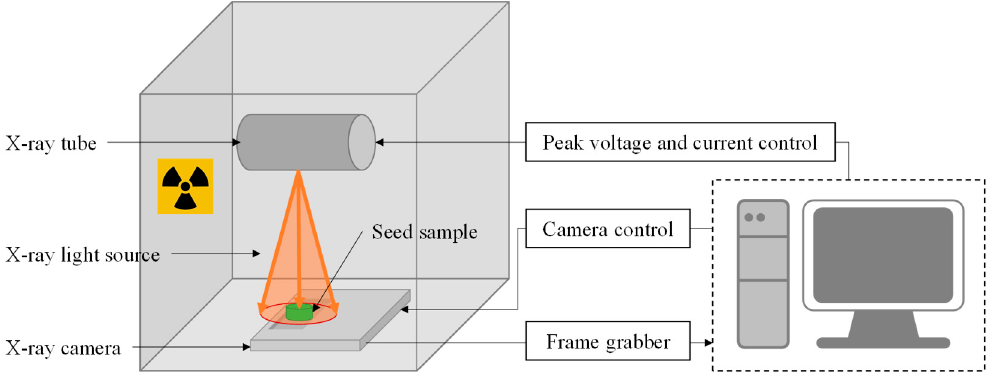
Figure 1. The schematic diagram of the soft X-ray imaging system .